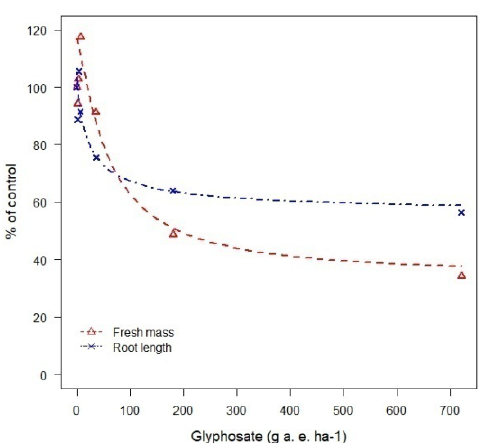
Figure 2. Soybean fresh mass and root length as influenced by glyphosate dose 45 days after treatment (DAT).